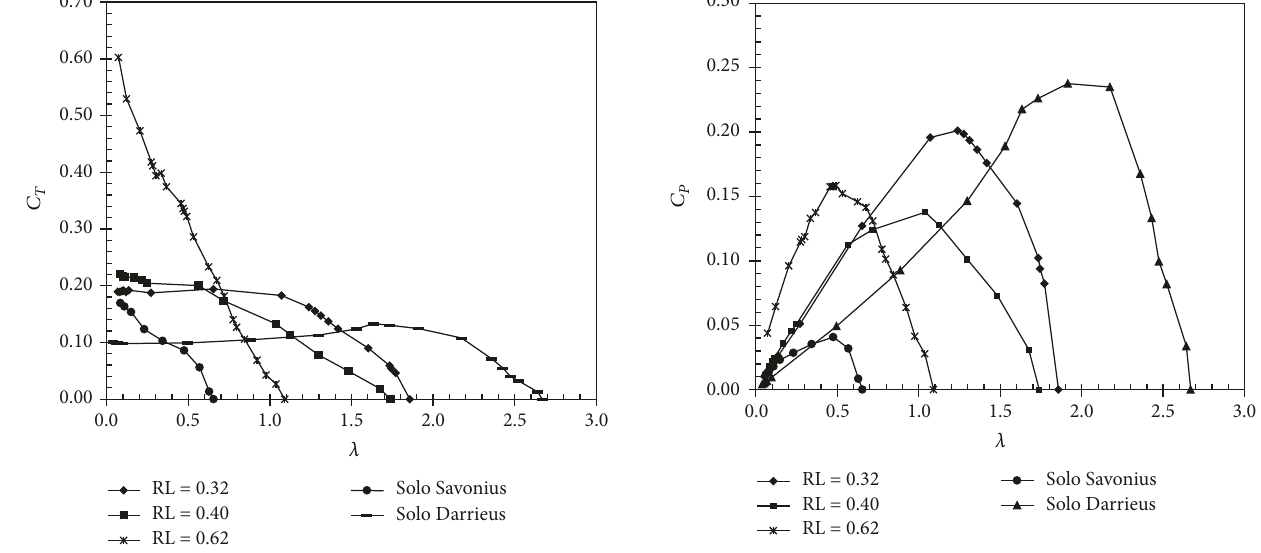
Figure 6: Torque coefficient variation (case (b)). Figure 7: Coefficient of power (case